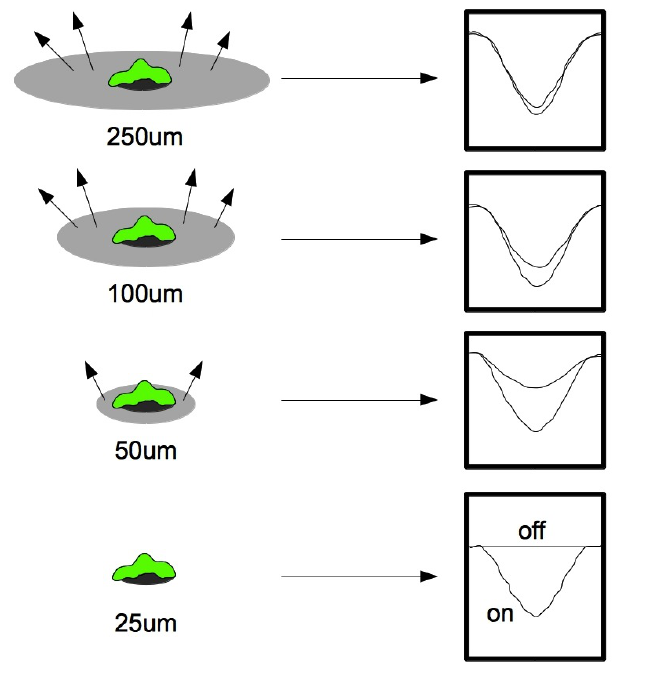
Figure 1. Electrochemical current response of microelectrodes for the presence of a